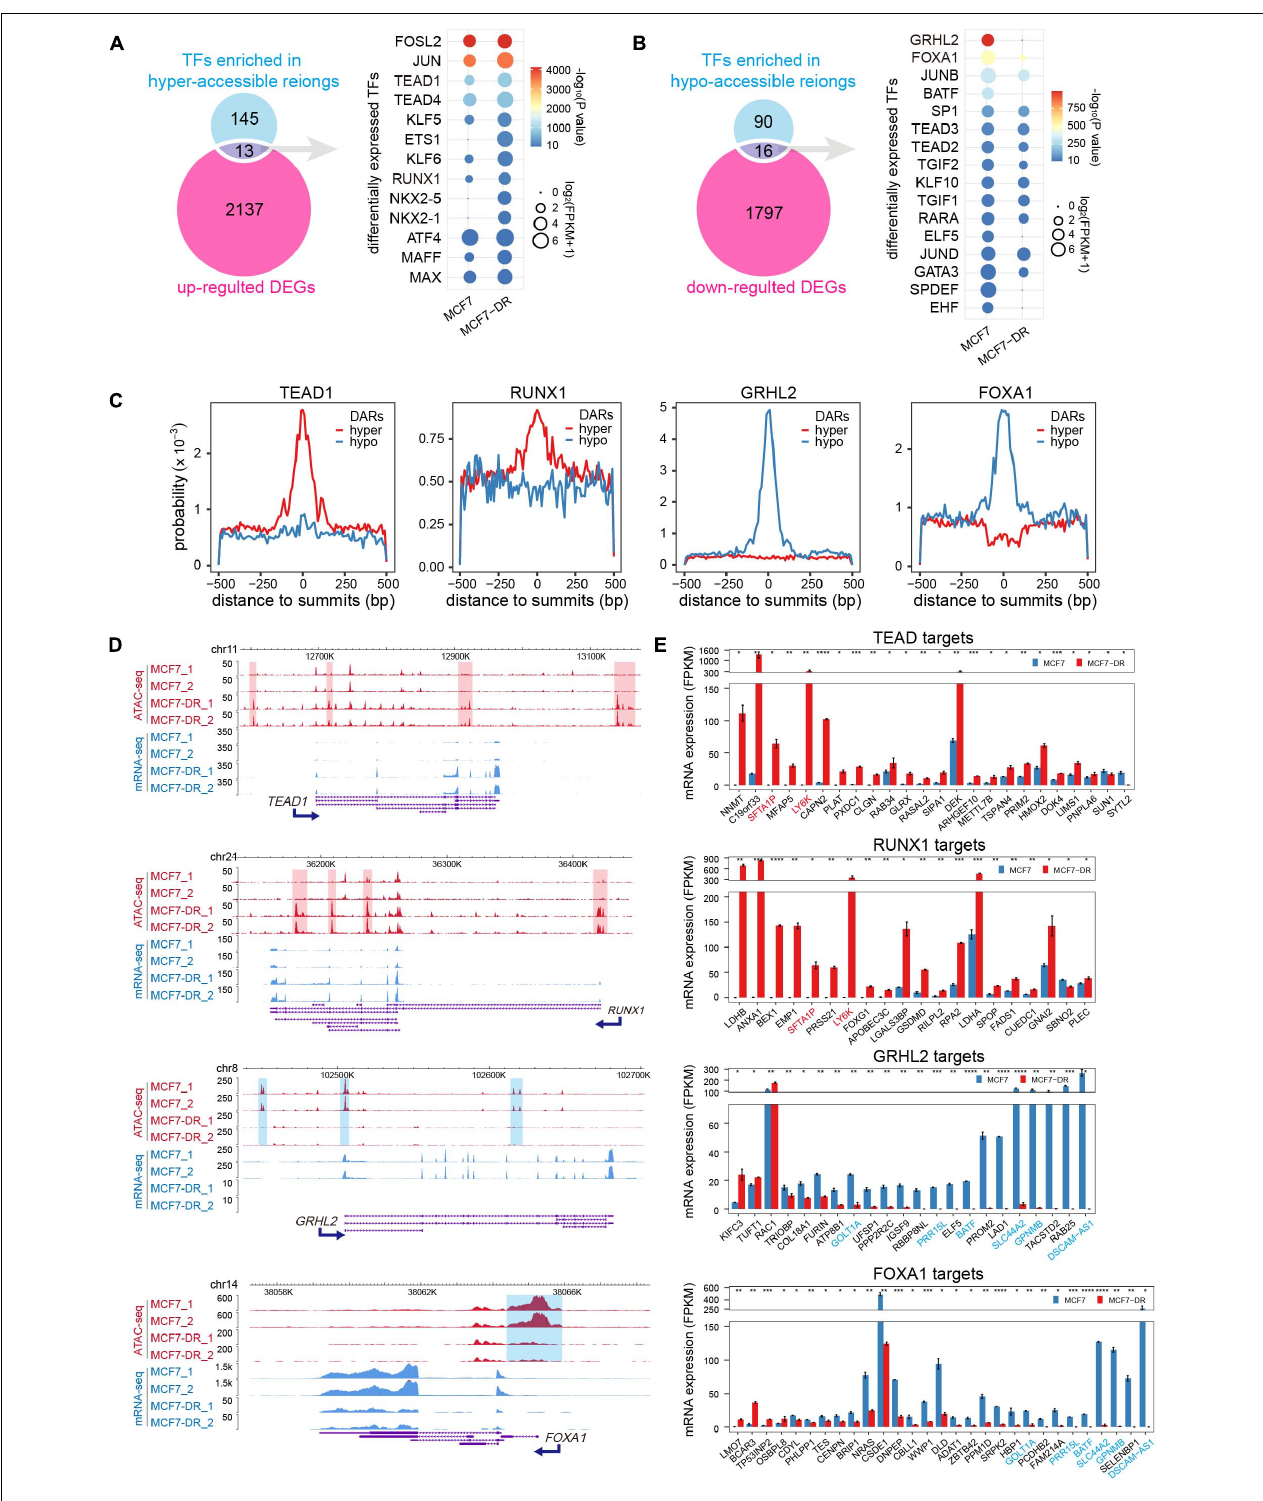
FIGURE 6 | Differentially expressed TFs (DETFs) and their target DEGs. (A) Venn diagram (left) showing overlap of the corresponding TFs for each motif in hyper-accessible regions and up-regulated DEGs. The dot plot (right) showing the identified up-regulated TFs. The color of each dot represents the P value of enrichment (calculated using the cumulative binomial distribution in HOMER v4.10) for each motif and cell type, and the size of each dot represents the gene expression (FPKM) of the enriched motif cognate TFs. Only TFs motif enrichment P value < 10 – 10 were included. (B) Venn diagram (left) showing overlap of